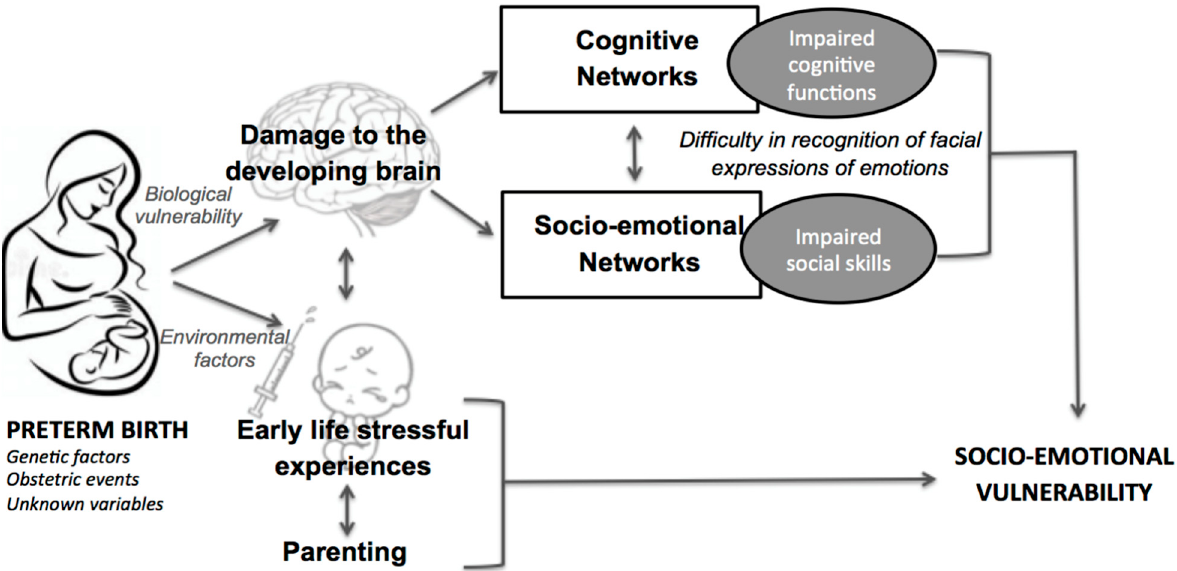
Figure 1. An integrative model showing the biological and environmental factors underlying preterm children's socio-emotional vulnerability. Adapted from Montagna and Nosarti, 2016.